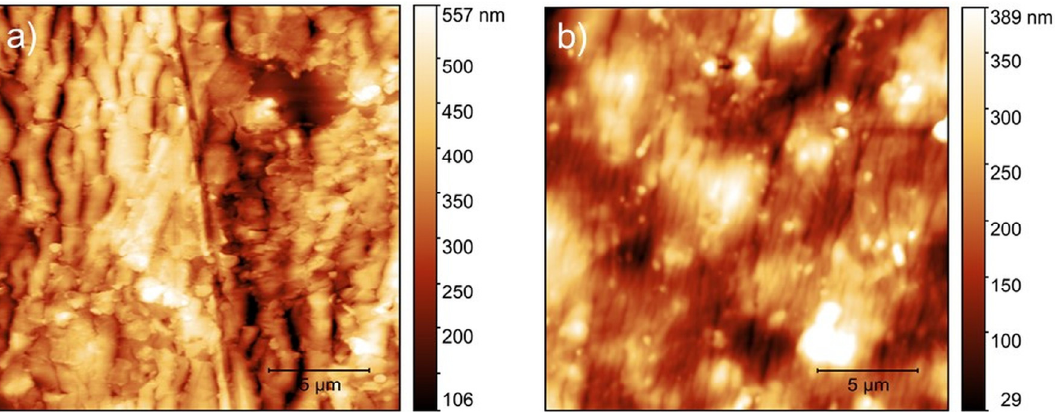
Figure 6. AFM images of the coated ( a ) and delaminated ( b ) CVC surface after tensioning.